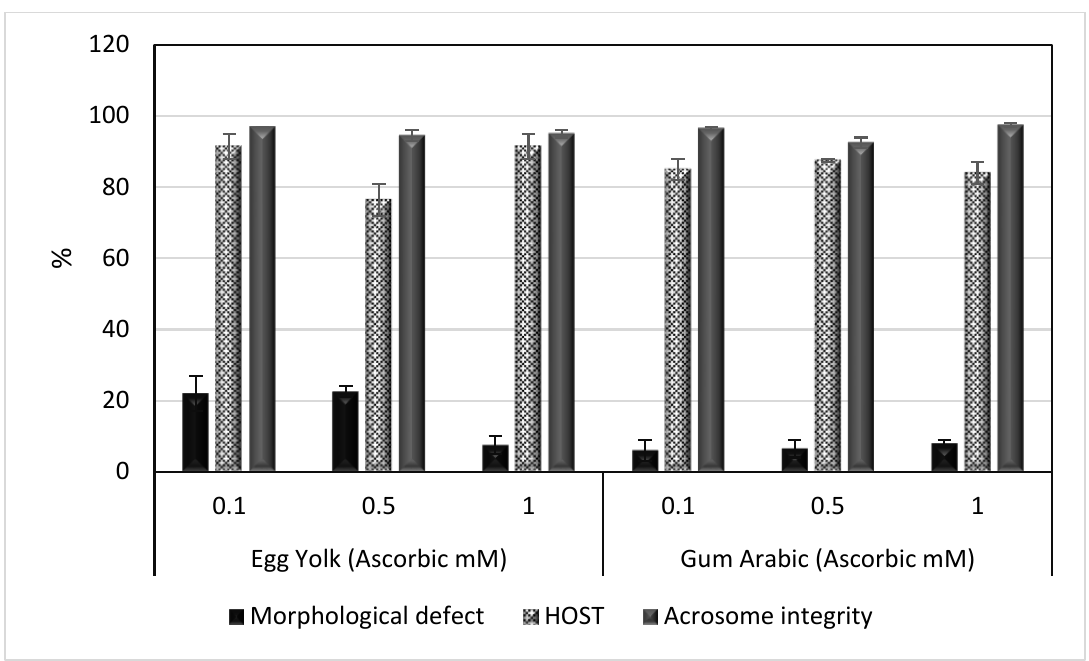
Figure 3. Mean ± SEM of morphological defects, HOST and acrosome integrity of spermatozoa in egg yolk or gum arabic extenders supplemented with different concentrations of ascorbic acid (0.1, 0.5 and 1 mM) after cooling. HOST: hypoosmotic swelling test.